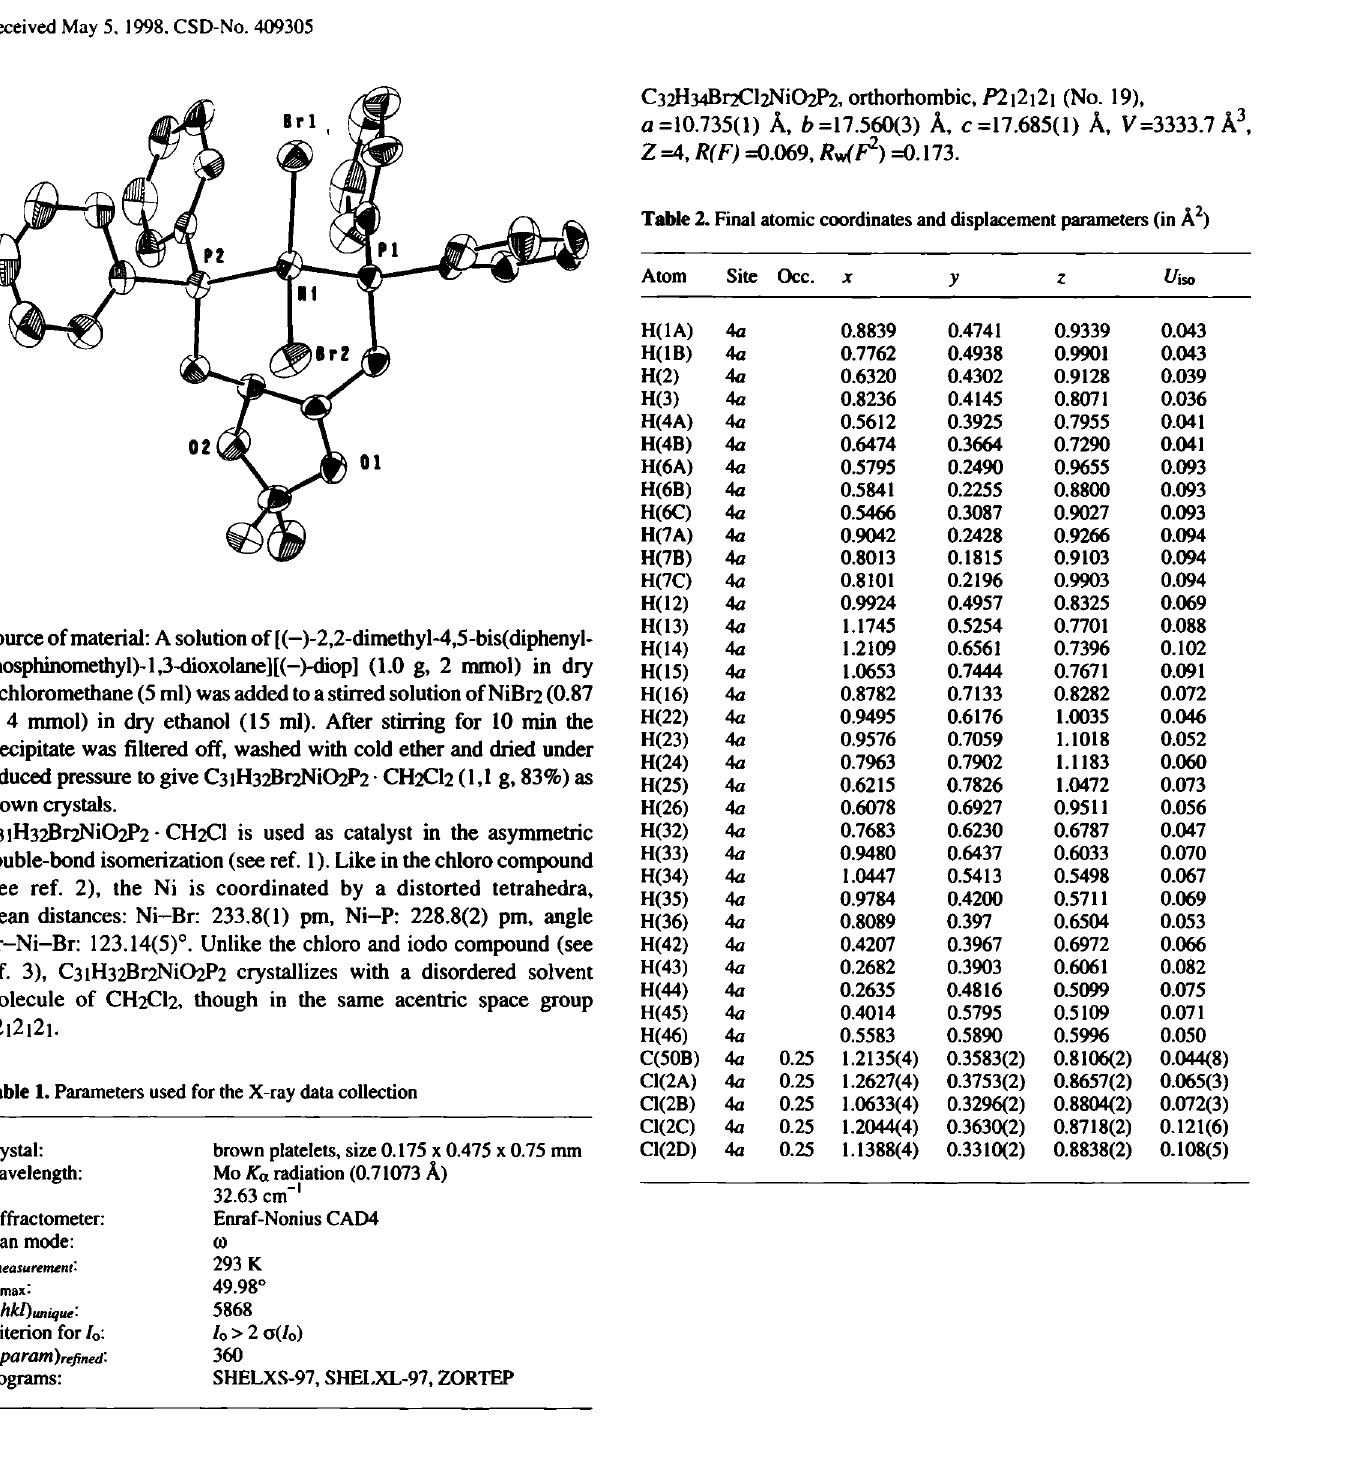
Table 2. Final atomic coordinates and displacement parameters (in Â^) Atom Site